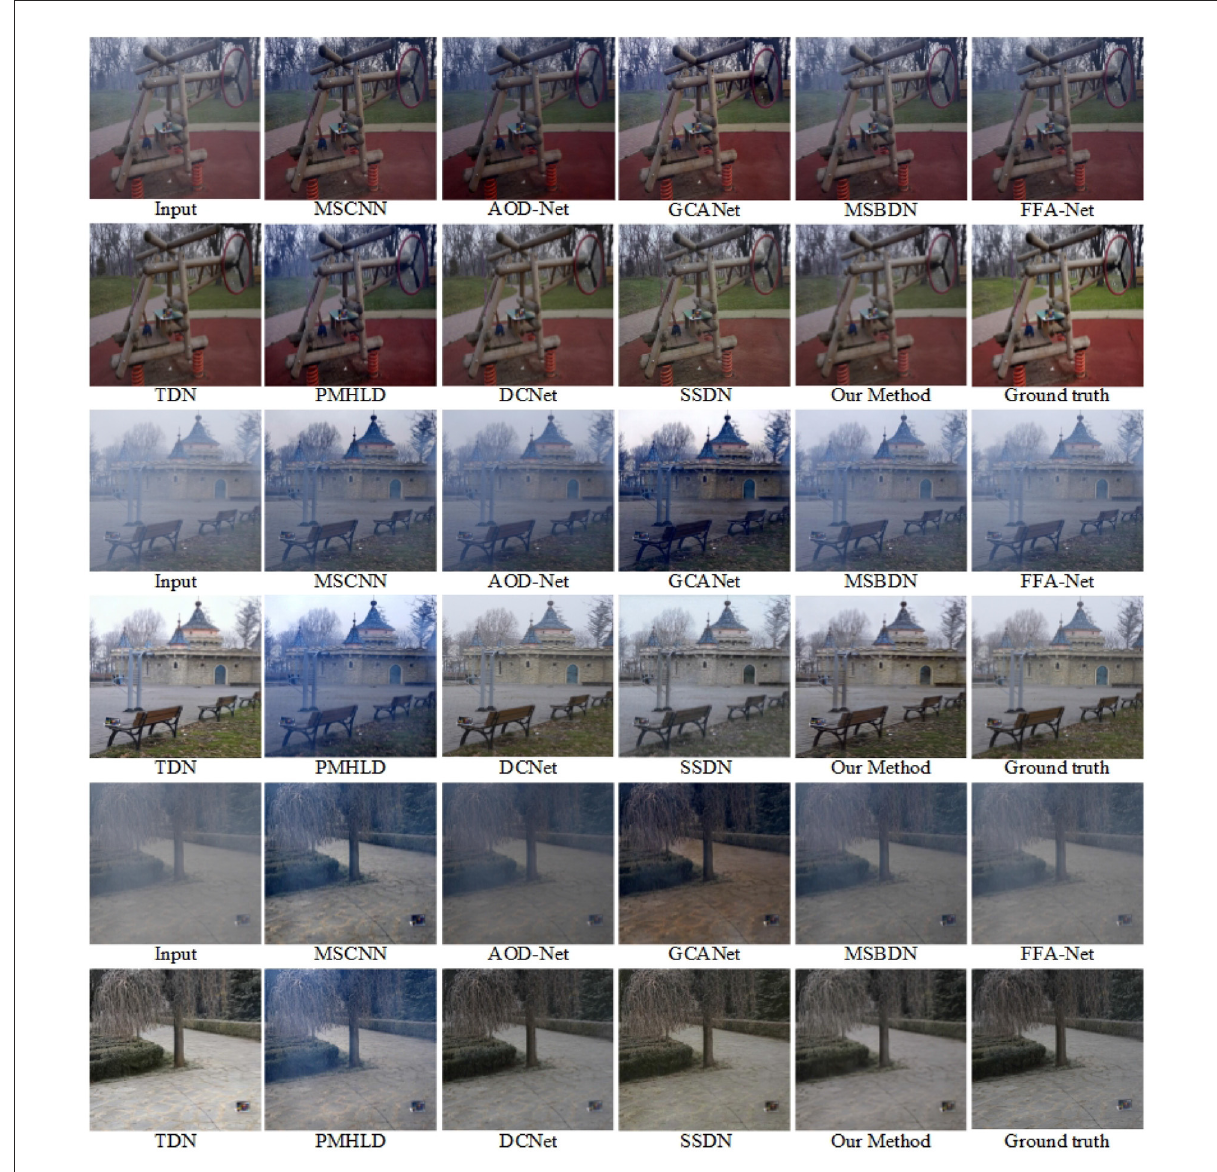
FIGURE6 Visual results on the O-HAZE dataset. Best viewed on a high-resolution